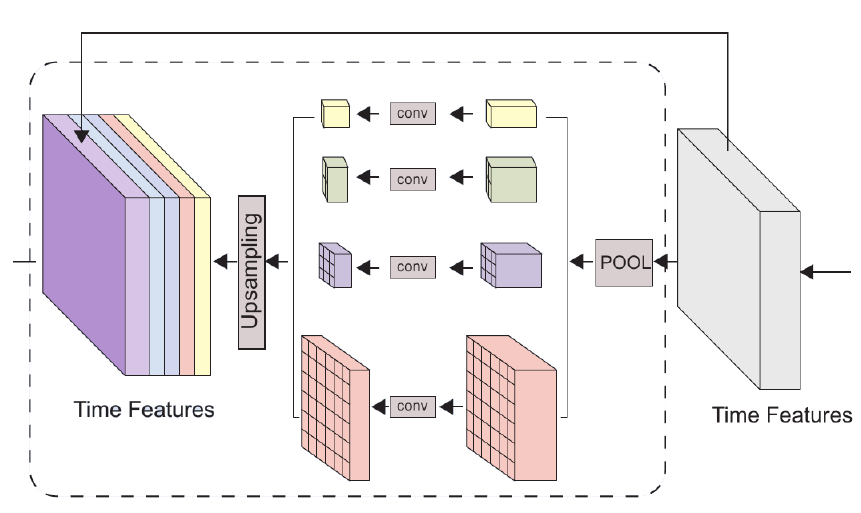
Figure 3. The Temporal Pooling